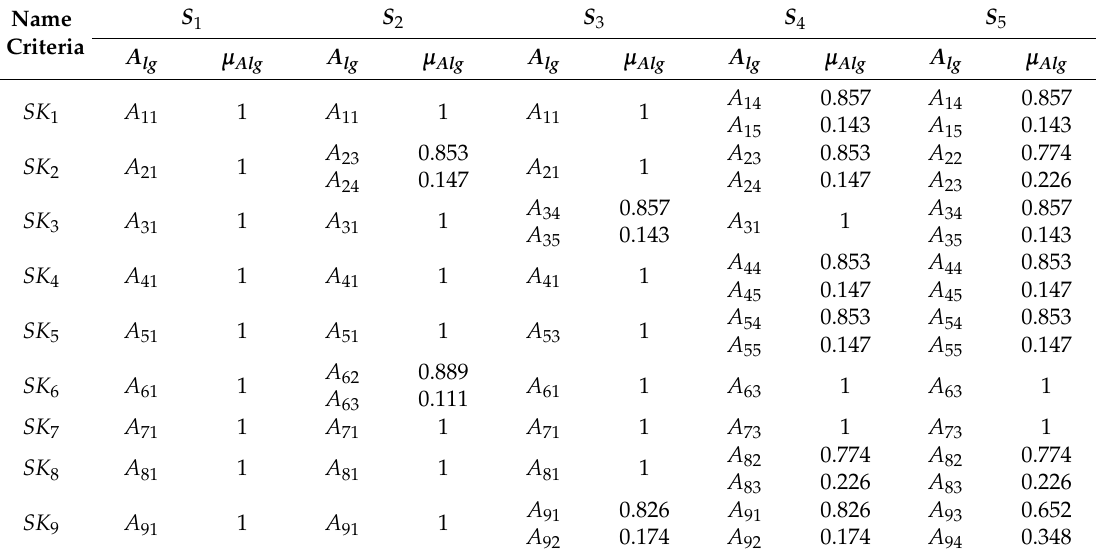
Table 5. Evaluating the usefulness of the start-up.